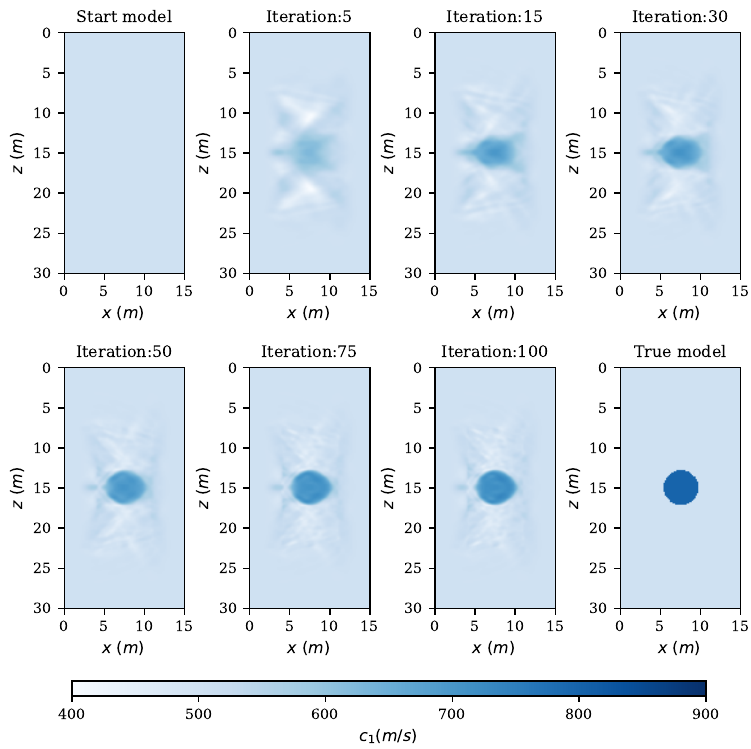
Figure 15. Longitudinal wave velocity inversion at different iteration steps in seismic FWI of a spherical inclusion in full-plane.